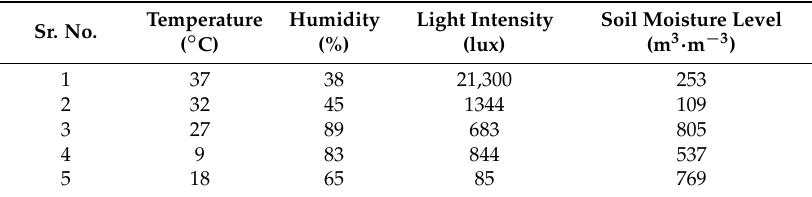
Table 8. Sensor data for the experiments.